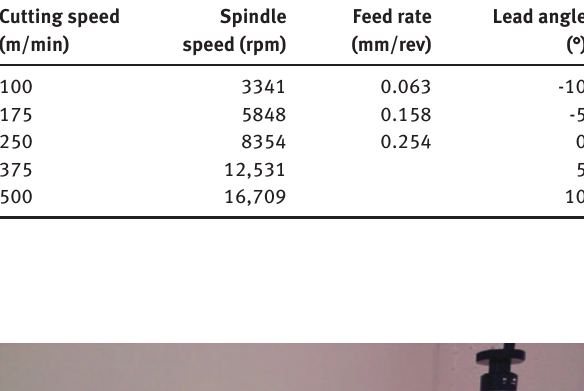
Table 3: Values of resultant cutting force (Fc) and surface rough- ness (R ) as a function of the cutting parameters (average of a